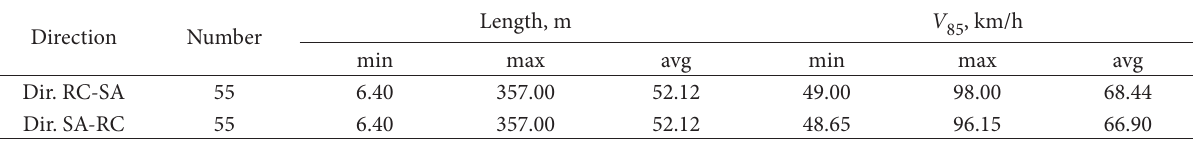
Table 3. Statistics for